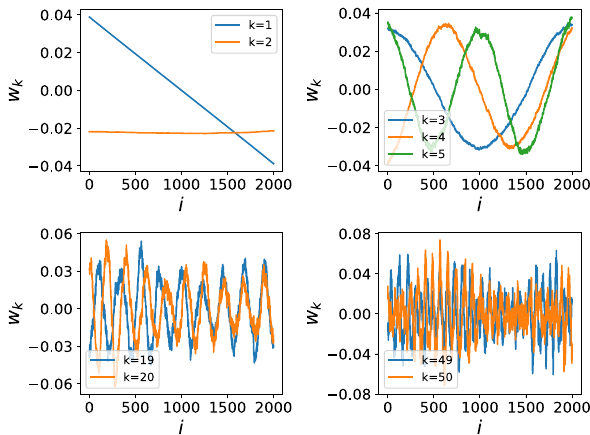
Figure 2. Behaviors of representative components W k , the first two dominant modes W 1 / 2 are non-fluctuating, representing two non-universal features of the eigenvalue spectrum. Higher components with k to the k th Fourier modes of the eigenvalues, therefore, components with smaller (larger) k describes level correlations on longer (shorter)